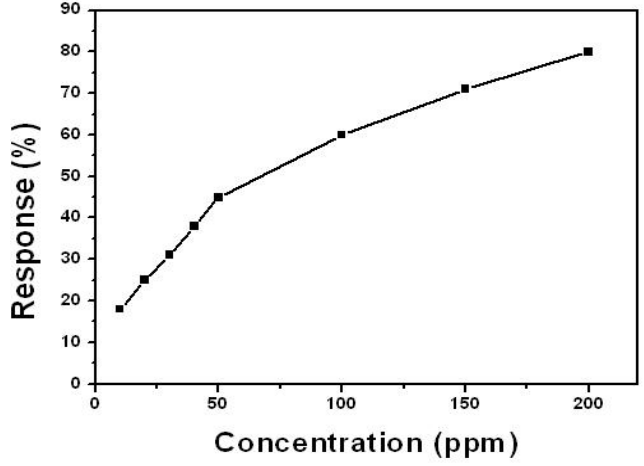
Figure 4. The normalized response of the SnO concentrations.